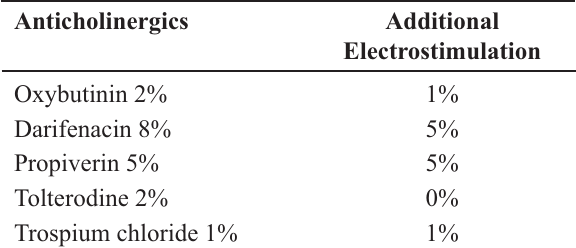
Table 3 – Preoperative treatment of the patients with mixed urinary incontinence.